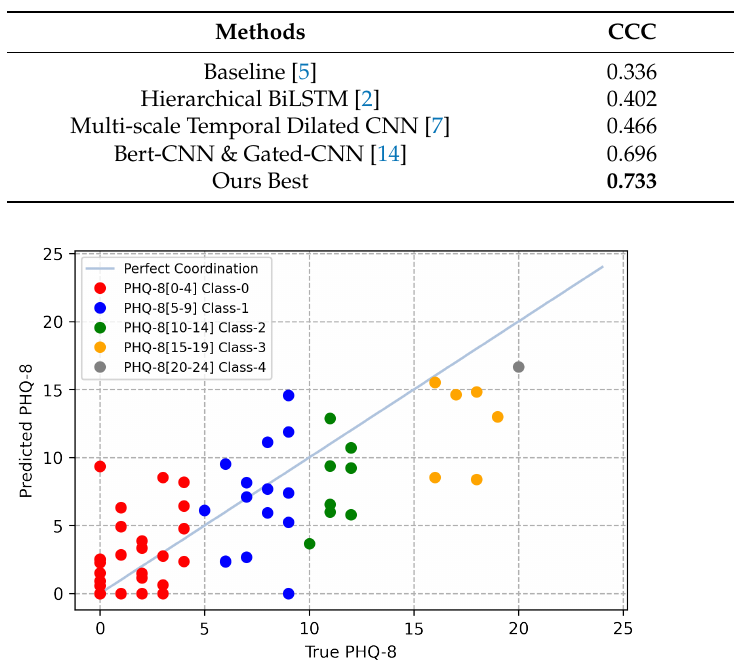
Table 6. Comparison of the proposed method and the state-of-the-art with CCC metrics and modali- ties used. The data in bold means the results with better performance.